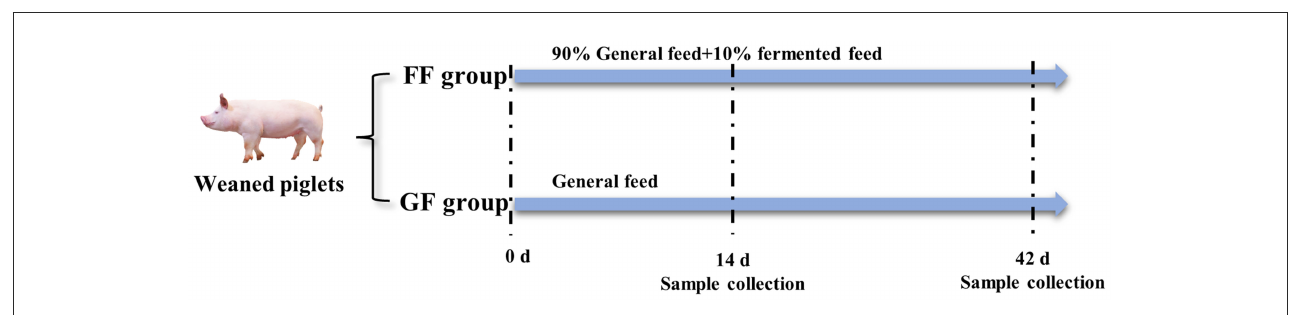
FIGURE2 Treatment of weaned piglets ( n = 120). The experiment was finished at the age of 42 days